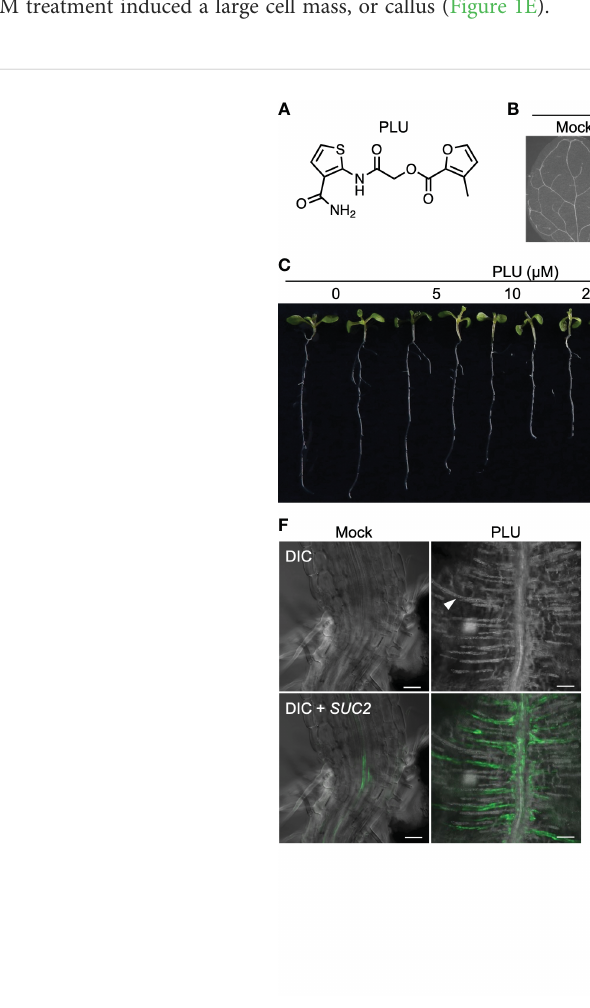
FIGURE 1 PLU induces abnormal venation patterns and the formation of callus. (A) The molecular structure of PLU. (B) Differential Interference Contrast (DIC) images of cleared true leaves of wild-type seedlings treated with DMSO (mock) or PLU from 1 to 11 days post inoculation (dpi). Scale bars: 200 m m. (C) PLU-treated seedlings. Scale bar: 1 cm. (D, E) Close-up image of roots below the hypocotyl-root junction at 20 µM treatment (D) and the hypocotyl- root junction at 40 µM treatment (E) . Scale bars: 100 m m. (F, G) SUC2pro:4xYFP reporter plants were treated with DMSO (mock) or 40 µM PLU at 1 dpi, and regions around the hypocotyl-root junction were observed at 8 dpi. Fluorescent signals of reporter lines were merged with DIC images. In DIC microscopy, thick secondary cell walls of xylem tracheary elements can be easily recognized (the white arrowhead indicates a representative signal). 20 µM PLU-treated AtHB8pro:4xYFP , SCRpro:4xYFP , and J0121:GFPer (G) . Insets show original expression patterns of the reporters in the roots of mock- treated plants. Scale bar: 50